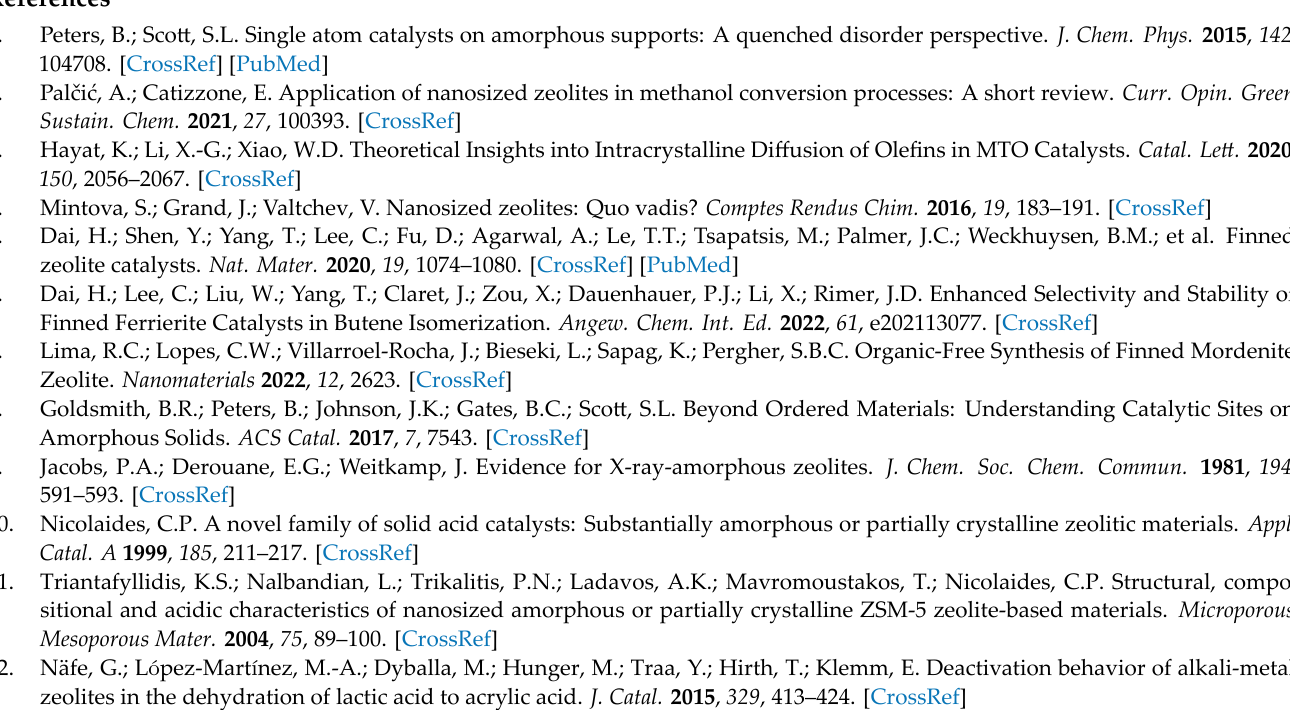
Figure S4: 27 Al MAS NMR spectra of the hydrated zeolites. Experimental spectra (black) and math‑ ematically deconvoluted spectra using Lorentzian lines (red and green) and overall mathematical fit (blue).; Table S1: Carbon content w c of the catalysts after the reaction.; Description of the